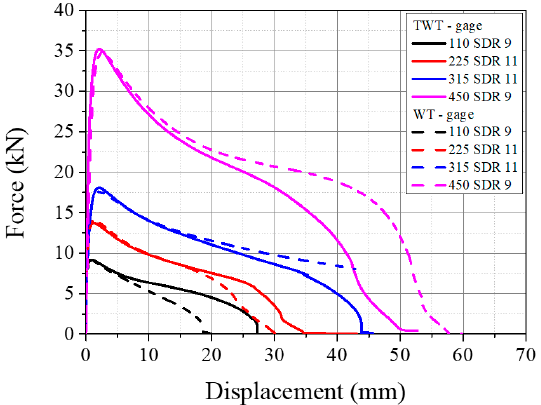
Figure 23. Load–displacement curves of TWT and WT specimens using a 20 mm gage length exten- someter.